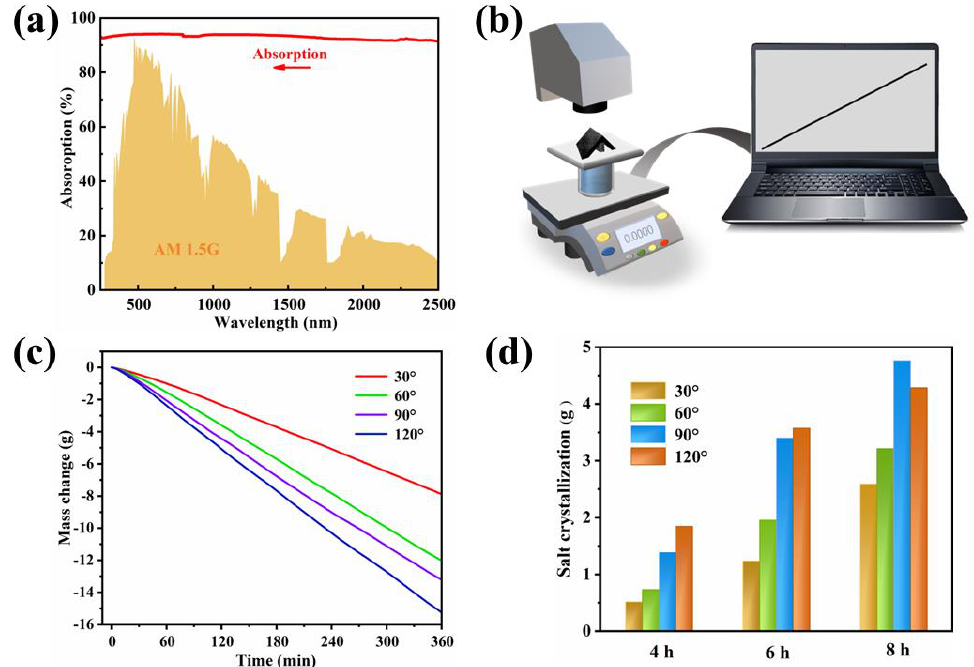
Figure 6. ( a ) Light absorption of crystallizer at the 250−2500 nm wavelength spectrum; ( b ) schematic of an indoor solar evaporation setup; ( c ) mass change of the brine over time at different crystallizer angles; ( d ) salt collection of different crystallizers within three durations of test.